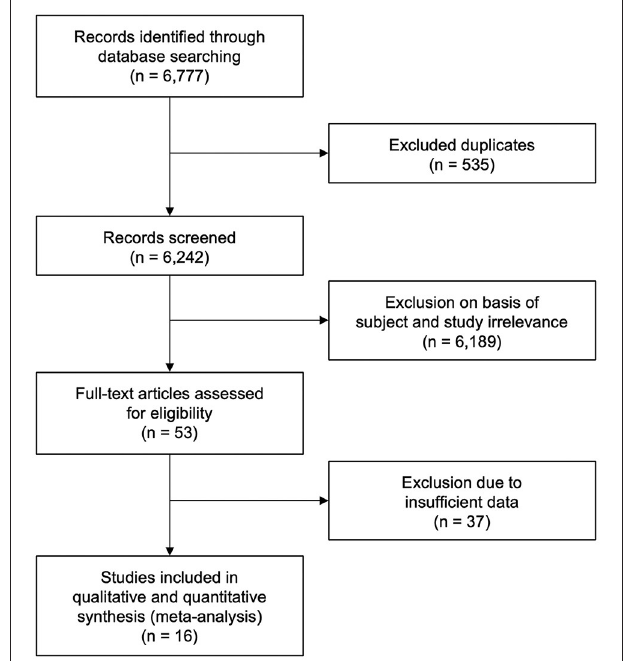
FIGURE 1 | Preferred Reporting Item for Systematic Reviews and Meta-Analysis (PRISMA) flow diagram showing study selection (